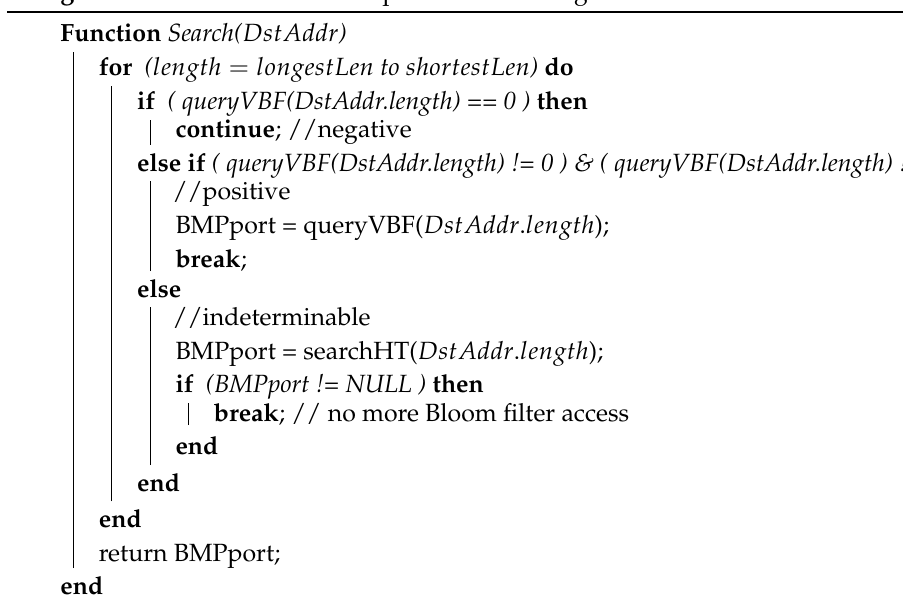
Algorithm 3: IP Address Lookup Procedure Using VBF Function